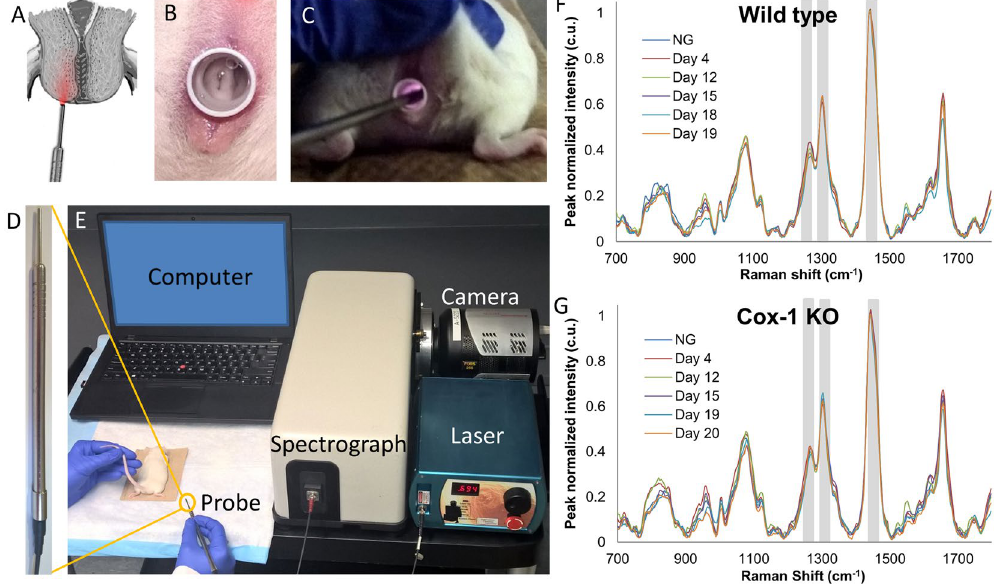
Figure 2. In vivo Raman spectroscopy system for cervical assessment during pregnancy. ( A ) Illustration showing the placement of the Raman spectroscopy fiber optic probe against the ectocervix of the mouse. ( B ) Mouse cervix visualized using a speculum. ( C ) In vivo Raman spectroscopy during measurement of mouse cervix. ( D ) Raman spectroscopy fiber optic probe. ( E ) Image of in vivo Raman spectroscopy system. Average Raman spectra from different time points during pregnancy in WT ( F ) and Cox-1 KO ( G ) mice. Gray boxes indicate regions that were highlighted in Figs